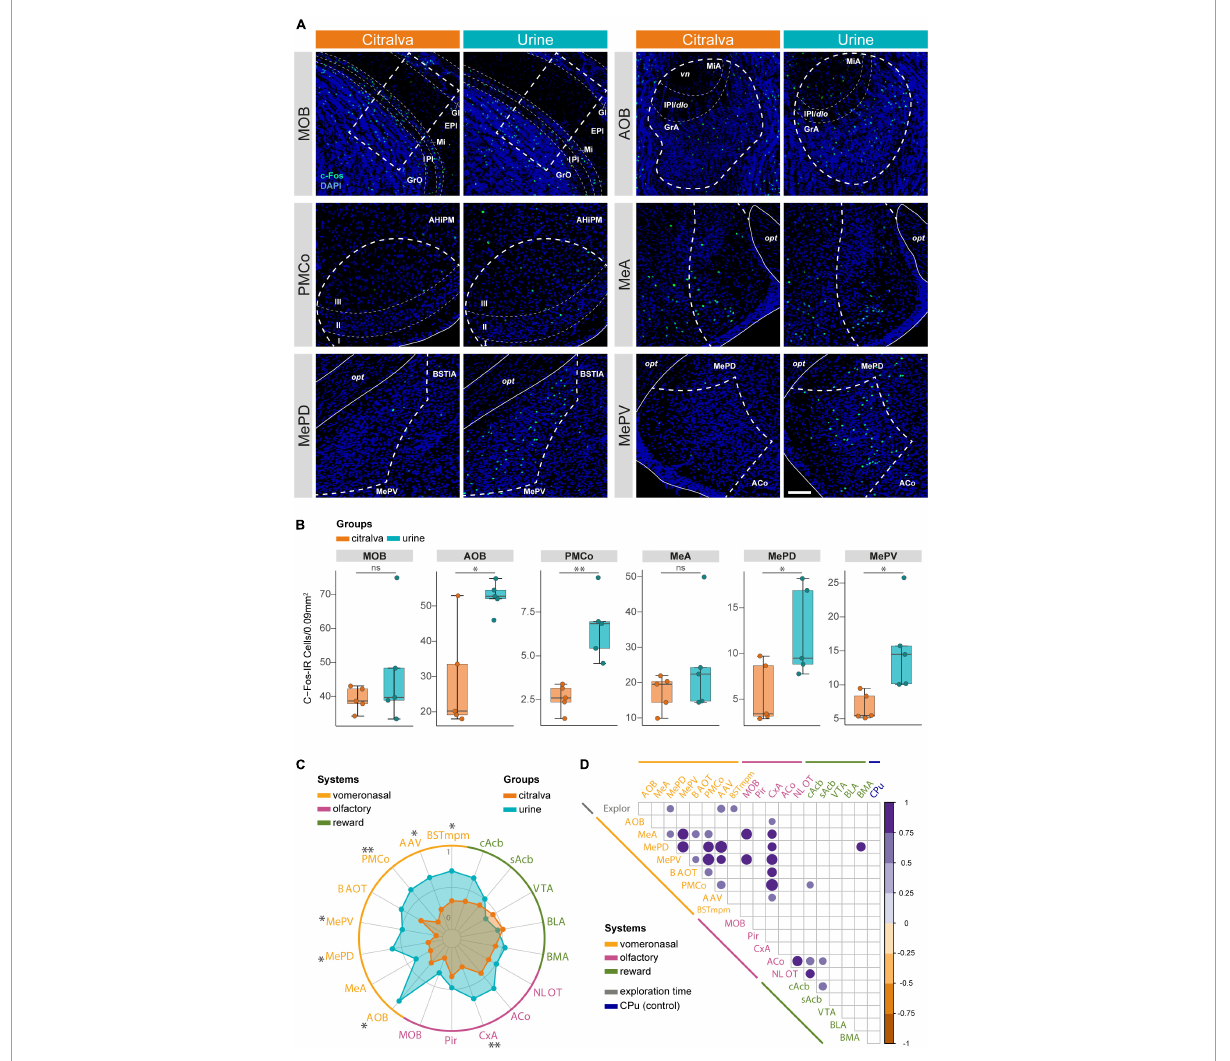
FIGURE9 Global analysis of the immunohistochemical expression of c-Fos in the extended chemosensory network. (A) Confocal microscopy Z-stacks illustrating differential c-Fos expression between citralva (orange, n = 5) and urine (blue, n = 5) groups, exemplified by the most relevant structures of the bulbo-amygdalar network. Thick dashed lines indicate counting ROI, narrow dashed lines give further layering detail for some nuclei, whereas solid lines and surrounding structures provide neuroanatomical clues to facilitate area identification. Scale bar in MePD urine panel, valid for all images: 100 µ m. (B) Group data distribution comparing cell activation density (c-Fos-IR cells/0.09 mm 2 ) between citralva and urine groups in the nuclei displayed in (A) . Box plots are defined in terms of minima and maxima by whiskers, and the center and bounds of box by quartiles (Q1–Q3). Outliers were identified by Tukey method and left in the analysis. Two-sided t or Mann-Whitney U test: ∗ p < 0.05; ∗∗ p < 0.01. Other comparisons are shown in Supplementary Figure 1 . (C) Extended analysis of the pattern of c-Fos-IR density in the vomeronasal (yellow), olfactory (magenta), and reward (green) circuits of female mice exposed to citralva or male urine. Each axis of the radar plot represents a measured nucleus. The vertices defining the colored polygons represent the mean of the Min-Max normalized data expressed for each group, illustrating the pattern of activity in both experimental groups within each system. Statistically significant structures are indicated with asterisks. Two-sided t or Mann-Whitney U test: ∗ p < 0.05; ∗∗ p < 0.01. (D) Correlogram displaying significant statistical correlations between pairs of variables, comparing altogether c-Fos cell density in all nuclei and exploratory behavior. Circle size and color represent Pearson’s correlation r -value and are only present when p < 0.05. Circle radius has been rescaled according to the minimum Pearson’s r -value which p -value was significant. AOB, accessory olfactory bulb; MeA, anterior medial amygdaloid nucleus; MePD, posterodorsal medial amygdaloid nucleus; MePV, posteroventral medial amygdaloid nucleus; BAOT, bed nucleus of the accessory olfactory tract; PMCo, posteromedial cortical amygdaloid nucleus; AAV, anterior amygdaloid area, ventral part; BSTmpm, medial posteromedial bed nucleus of the stria terminalis; MOB, main olfactory bulb; Pir, piriform cortex; CxA, cortex amygdala transition area; ACo, anterior cortical amygdaloid nucleus; NLOT, nucleus of the lateral olfactory tract; cAcb, nucleus accumbens core; sAcb, nucleus accumbens shell; VTA, ventral tegmental area; BLA, basolateral amygdaloid nucleus; BMA, basomedial amygdaloid nucleus; CPu, caudate putamen (striatum); Explor, exploration time; GrO, granule cell layer of the MOB; IPl, internal plexiform layer of the MOB; Mi, mitral cell layer of the MOB; EPl, external plexiform layer of the MOB; Gl, glomerular layer of the MOB; GrA, granule cell layer of the AOB; IPl/dlo, internal plexiform layer of the AOB/dorsal lateral olfactory tract; MiA, mitral cell layer of the AOB; vn, vomeronasal nerve; AHiPM, posteromedial amygdalohippocampal area; opt, optic tract; BSTIA, intraamygdaloid bed nucleus of the stria terminalis; IR,